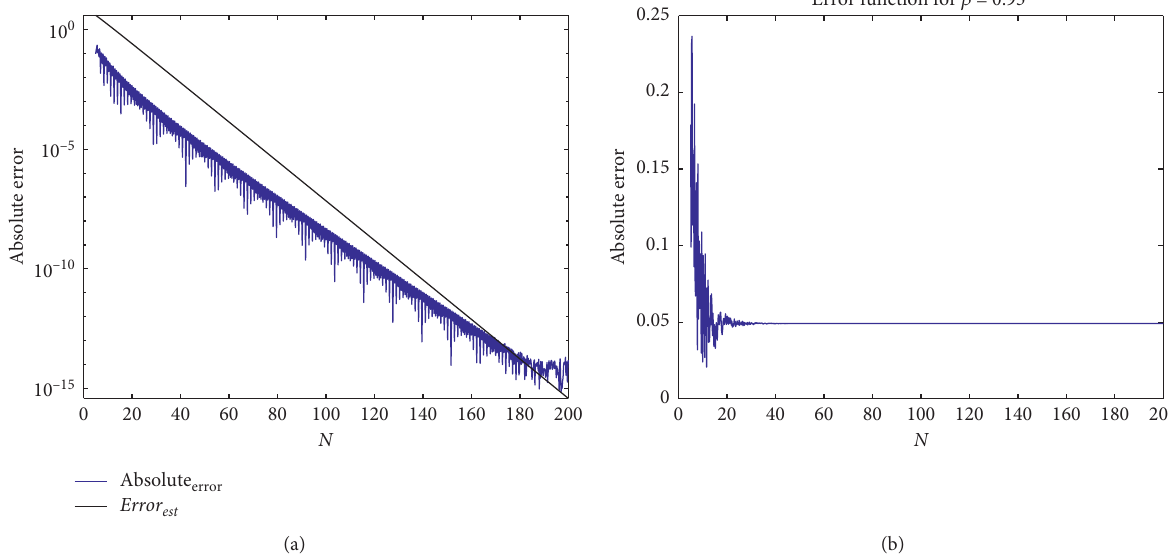
at x � 1 and β � 1 for Problem 5; a good agreement between them is est